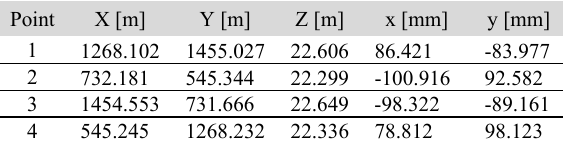
Table 5. Four control points measured in the perspective image.